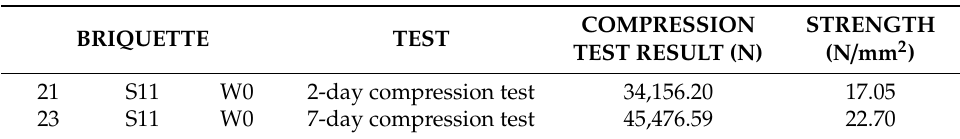
Table 14. Compression test results after 2 and 7 days.